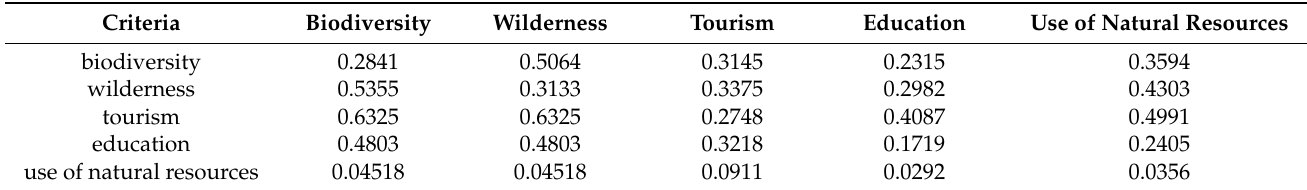
Table 4. DEMATEL total relations